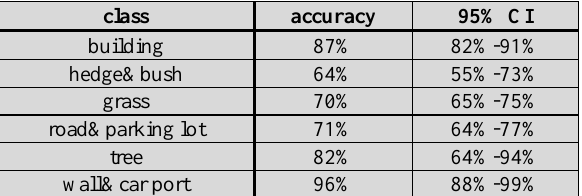
Table 7. Producer’s accuracy of the individual classes (SVM- classification)